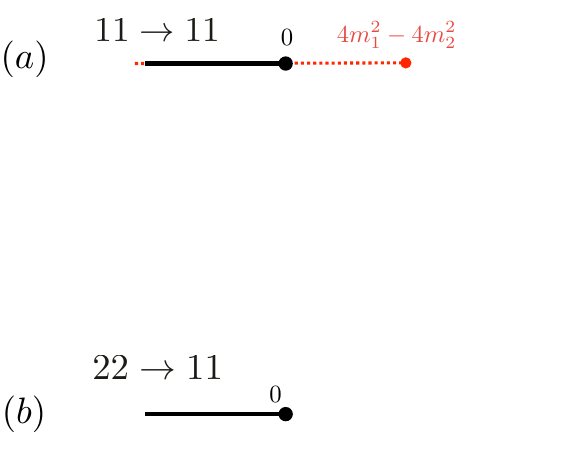
Figure 18. If m 2 < m 1 then the amplitude M 22 region which is bounded by the extended unitarity region in M 11 large or unitarity will be violated in the physical regions (in solid